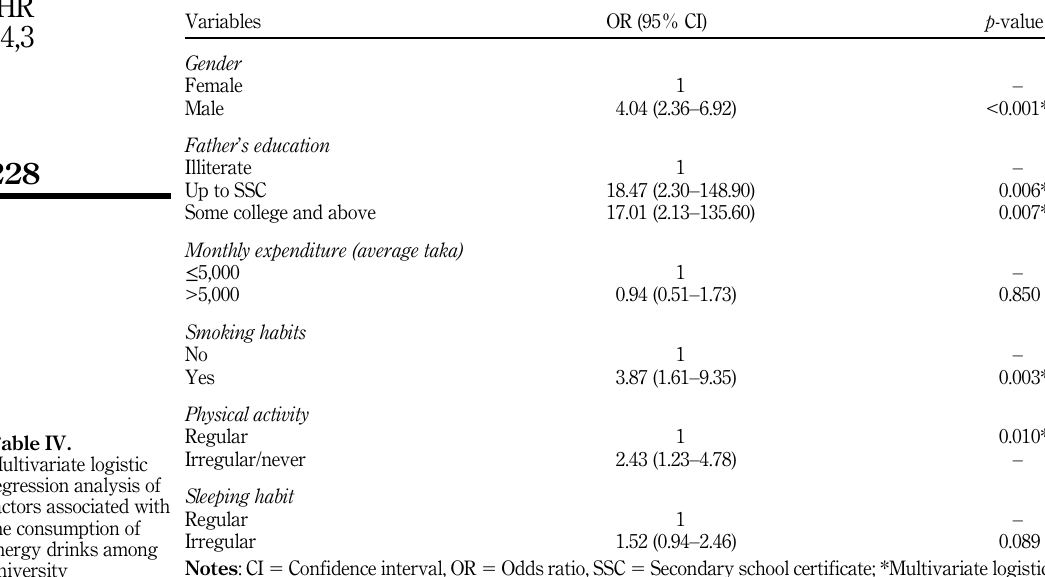
Table IV. Multivariate logistic regression analysis of factors associated with the consumption of energy drinks among university students ( n 5